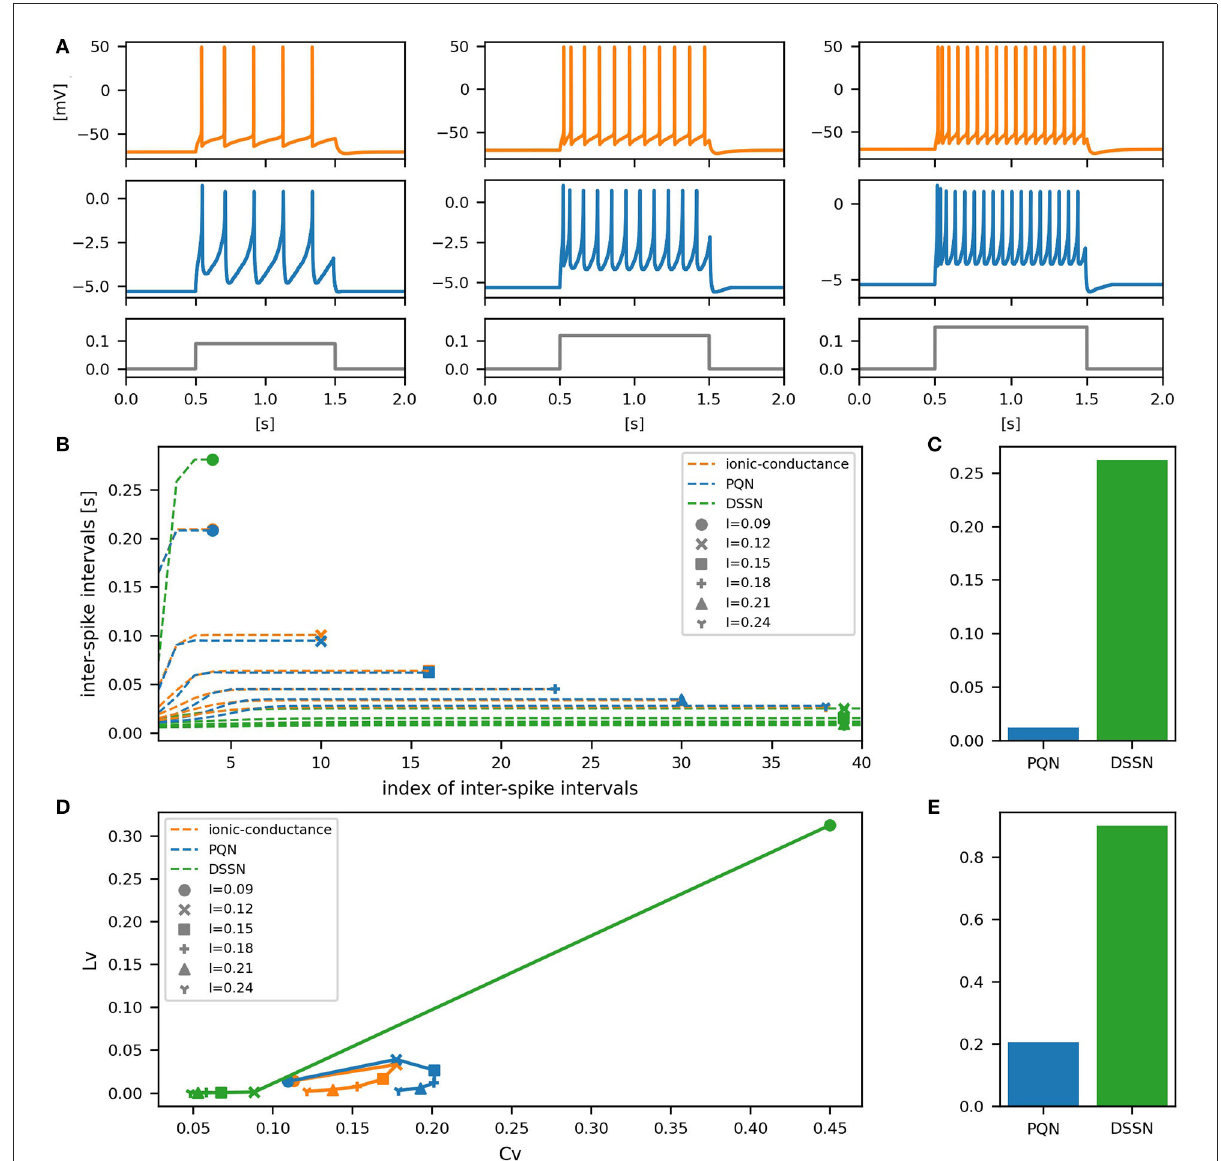
FIGURE8 Waveforms and spiking properties in FS mode. (A) Waveforms of the ionic-conductance model (orange) and the PQN model (blue). Gray lines represent stimulus inputs. (B) The transitions of ISIs are shown while increasing the magnitude of the stimulus input. (C) The mean square errors of the PQN model and the DSSN model with the ionic-conductance model over the data points shown in (B) . (D) Values of the C V and L V were calculated from the waveforms and plotted while varying the magnitude of the stimulus inputs. The waveforms used here are the same as that used in (B) . (E) The mean square errors of the PQN model and the DSSN model with the ionic-conductance model over the data points shown in (D) .